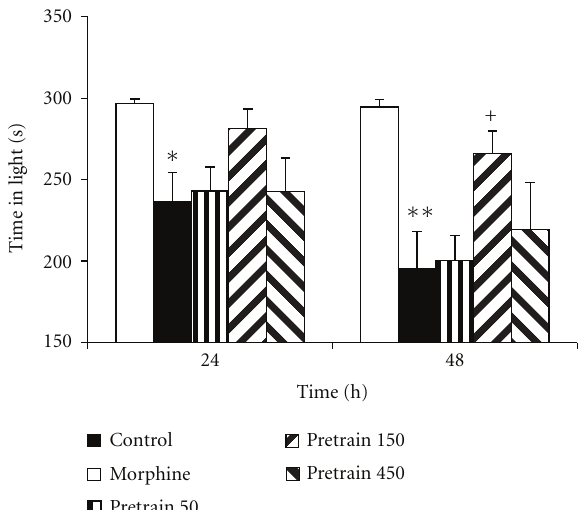
Figure 5: Comparison of the total time spent in the dark compartment in the experimental groups. The animals of the control group received saline instead of both sa ff ron extract and morphine. The animals of morphine group were treated by saline instead of SE but received morphine (5mg/kg, s.c.) 30 min before the training phase. Pretest 150 and pretest 450 groups were treated by 150 and 450mg/kg of SE (i.p.), respectively, before the recall phase. The data were presented as mean ± SEM of the total time spent in the dark compartment (8 animals in each group). ∗∗ P < 0 . 01 compared with the control; + P < 0 . 05 and ++ P < 0 . 01 compared with the morphine group.